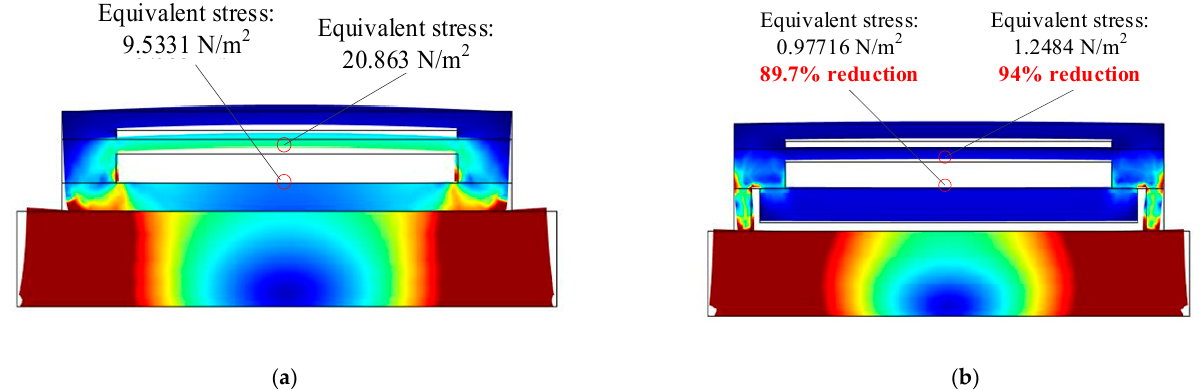
Figure 5. Structural design of the MEMS chip.